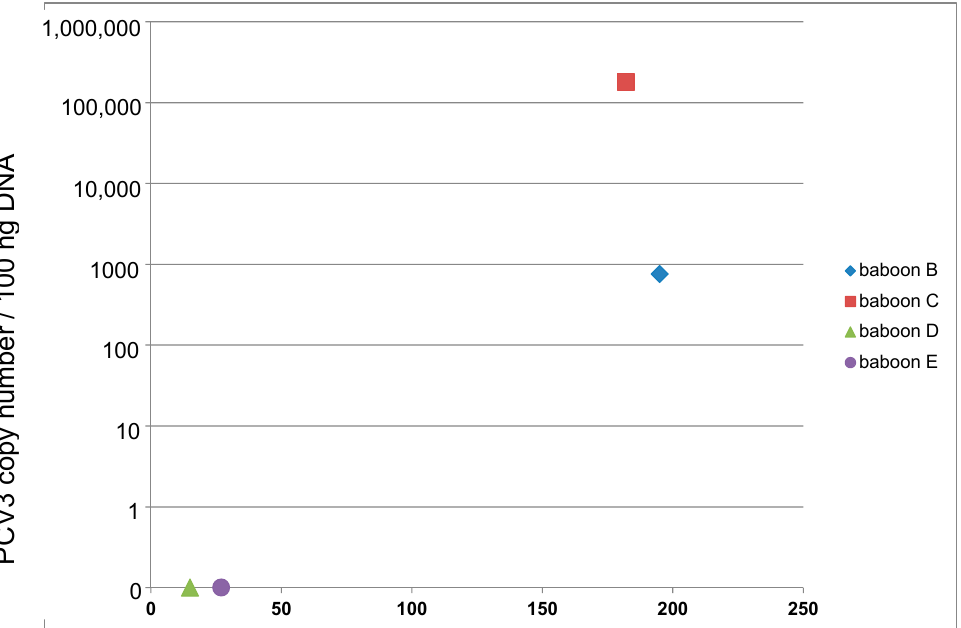
4 of 12 Figure 1. Detection of PCV3 in the organs of four PCV3-positive donor pigs (green hatched), in the